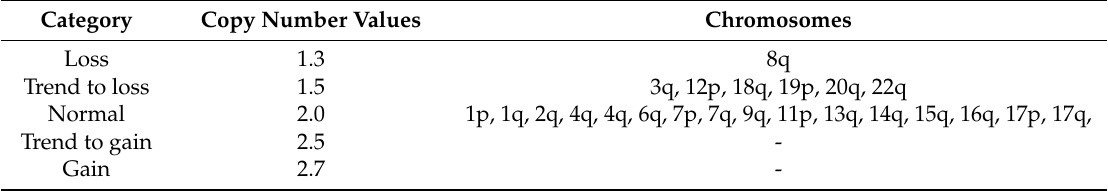
Table 4. Copy number variations in hiPSCs with the loss of chromosome